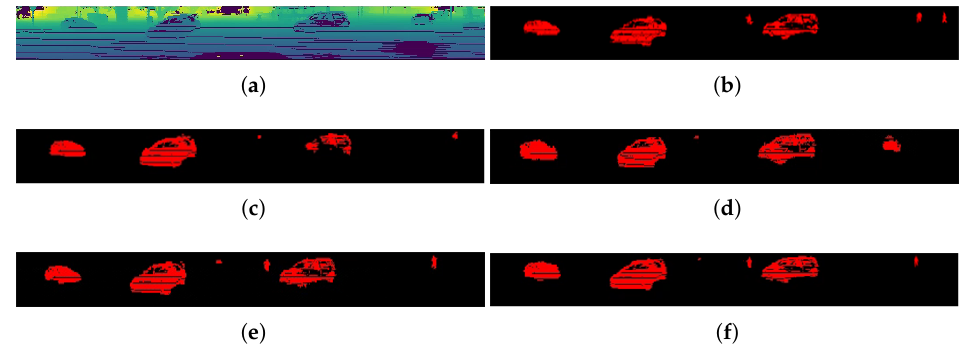
Figure 3. Qualitative results of different methods on the SemanticKITTI test set, where red pixels correspond to moving objects (range view images). ( a ) Range Image; ( b ) Ground Truth Labels;